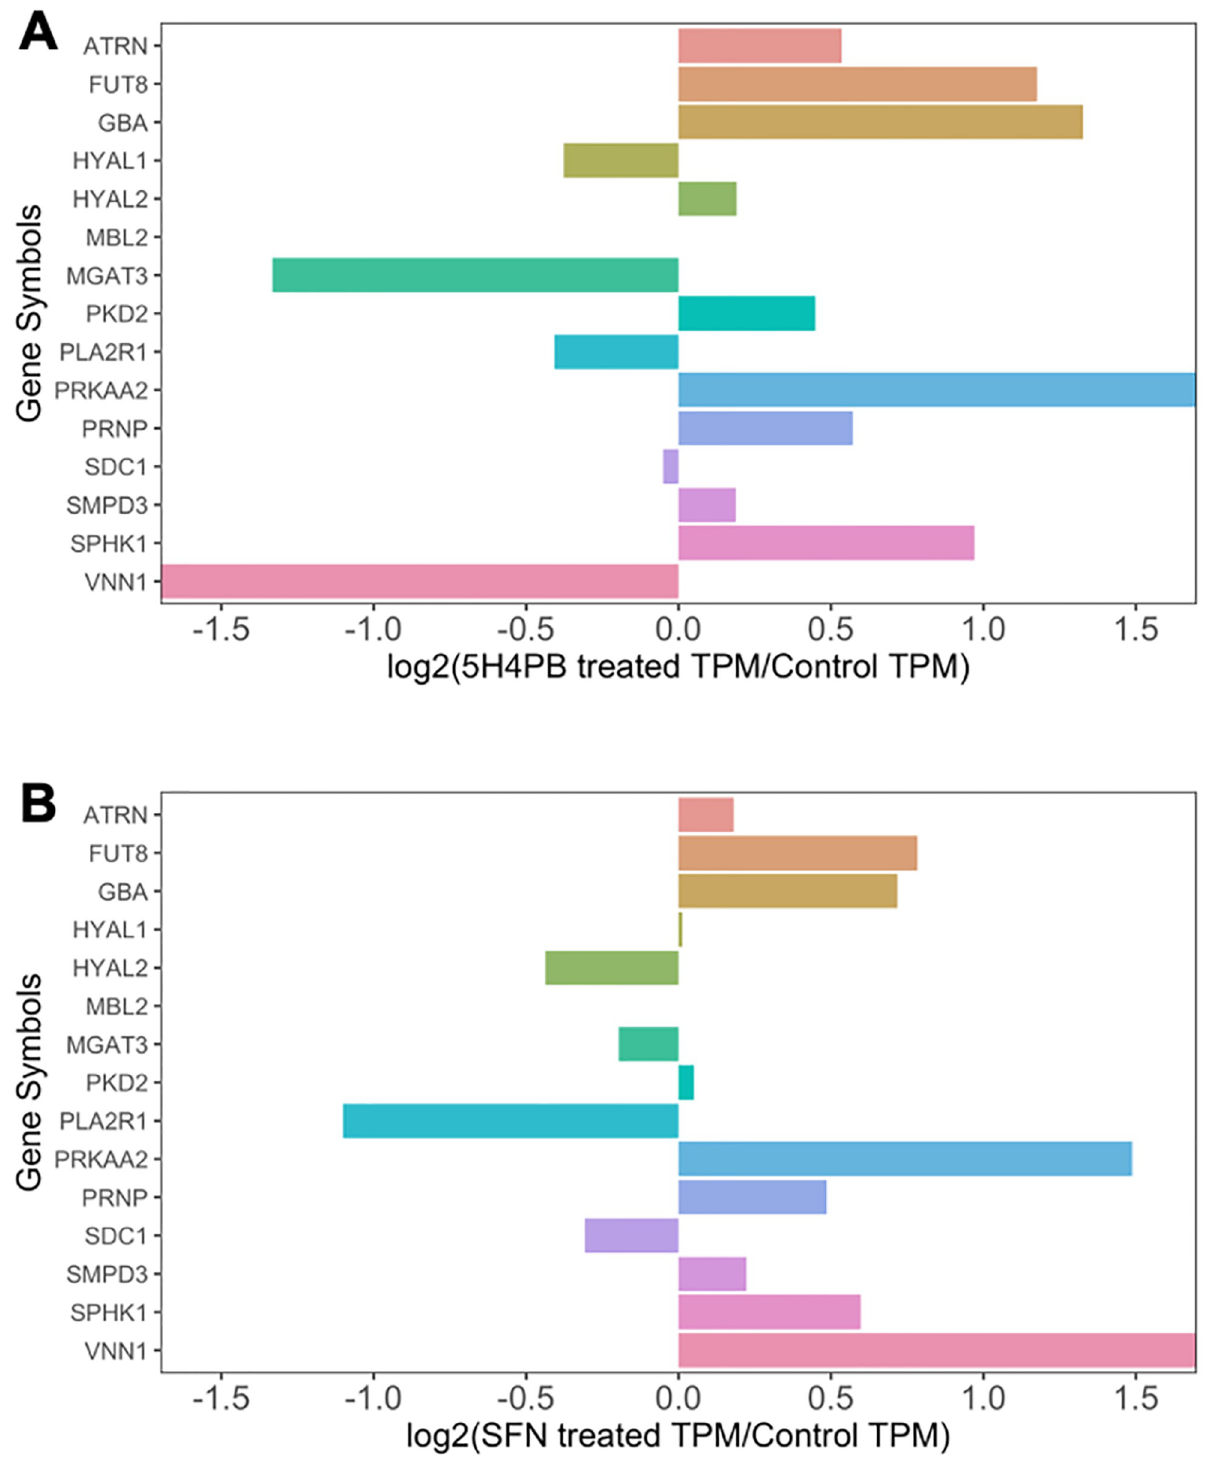
Fig 1. Expression of the 15 common genes in antioxidant-treated cells.